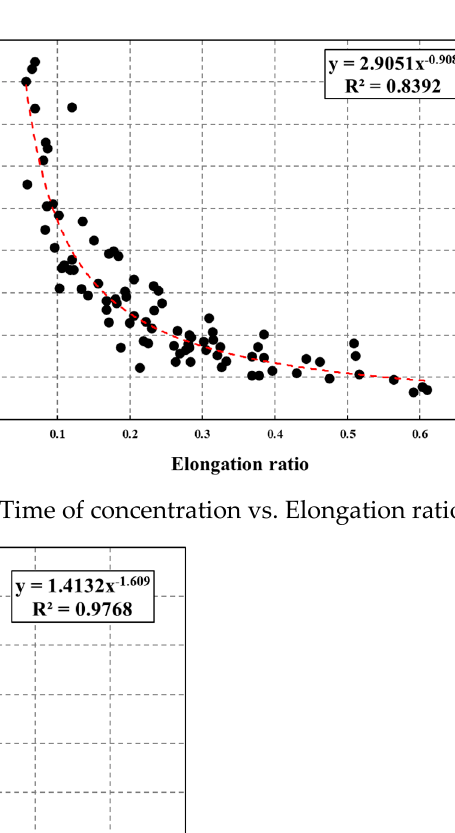
Figure 12. Time to peak of sub-watershed in the study.